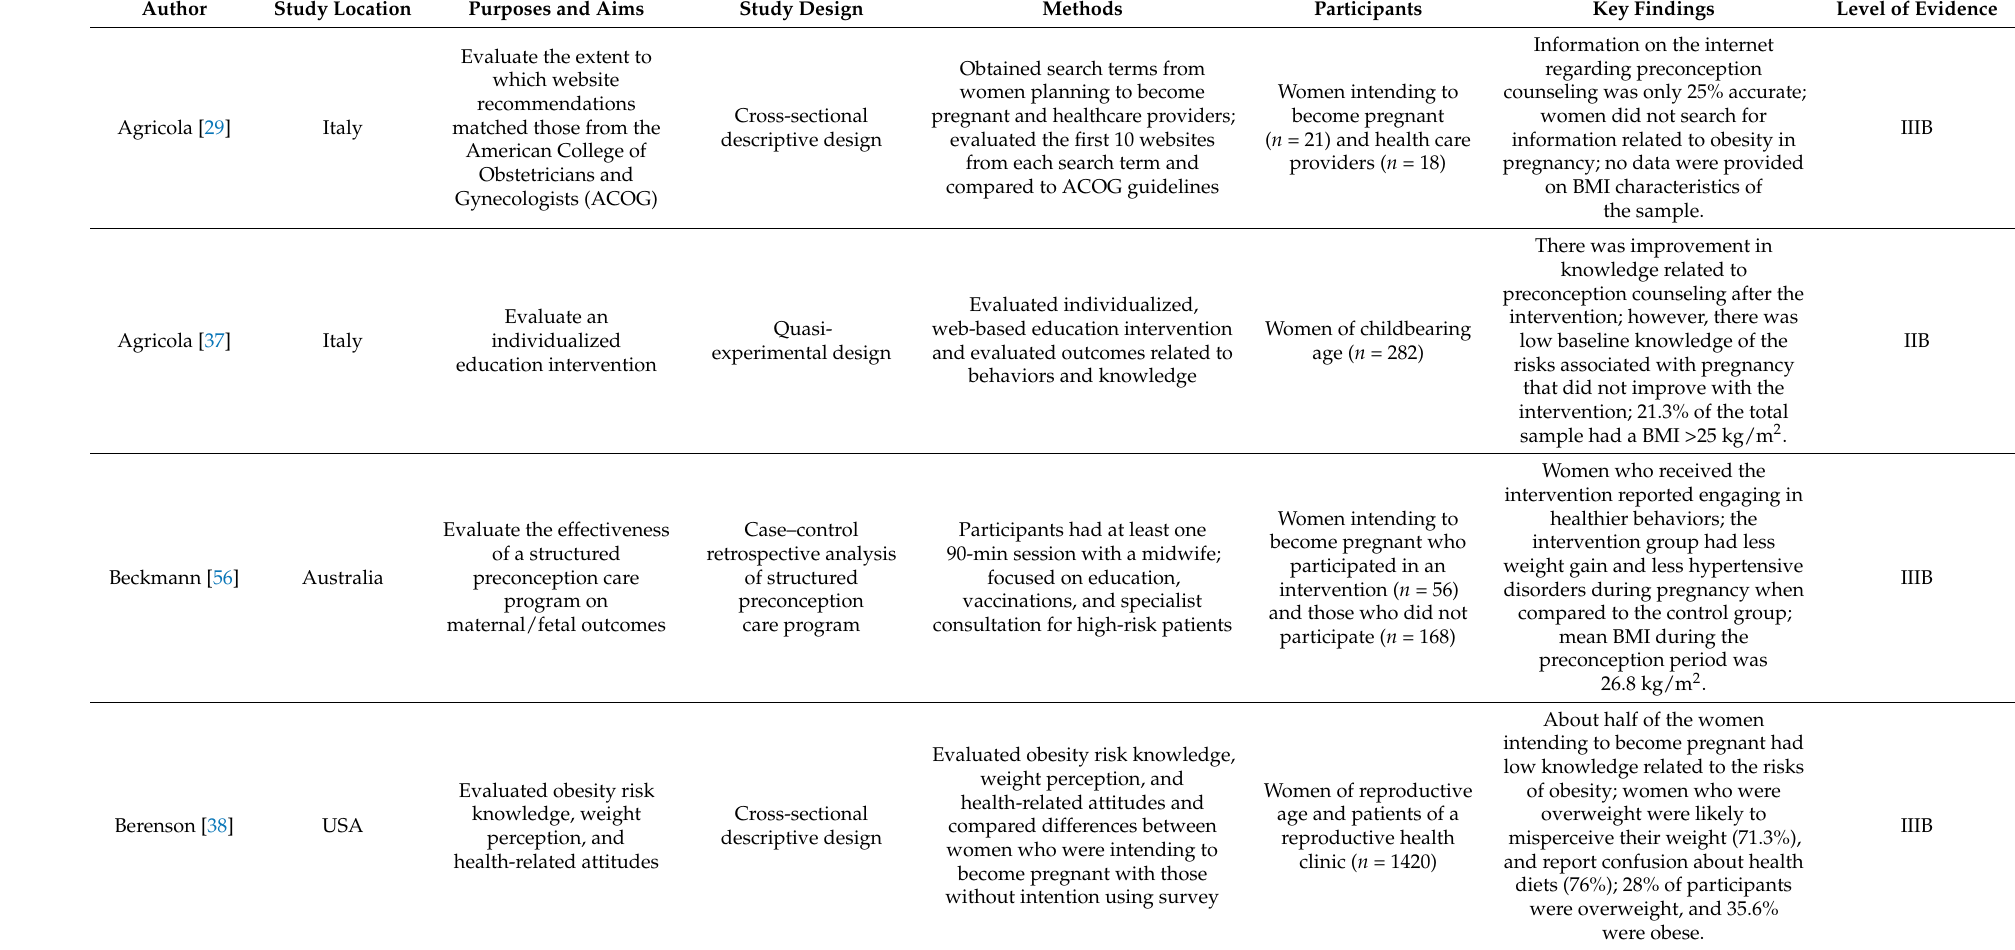
Table 1. Summary of full-text, data-based articles written in